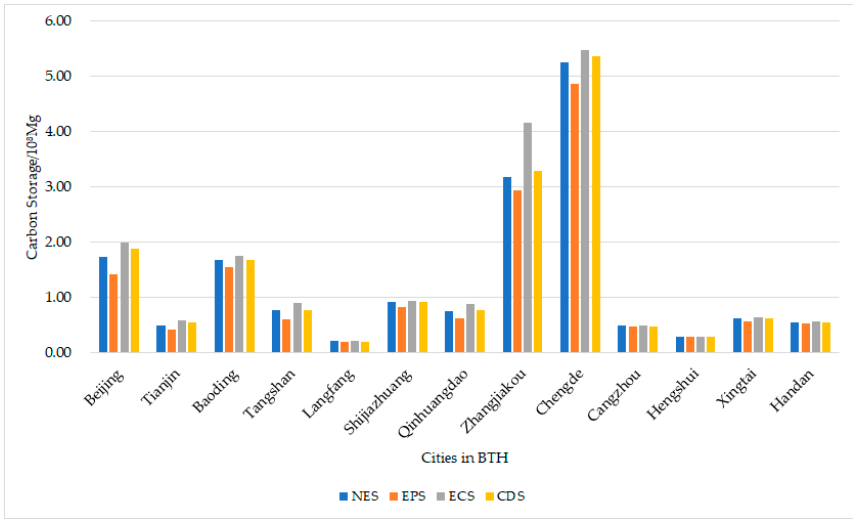
Figure 13. The predicted carbon storage of cities in 2050 under four scenarios.